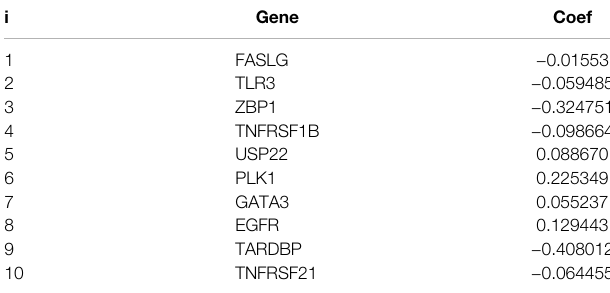
TABLE 1 | Coef fi cients in the LASSO Cox regression model.